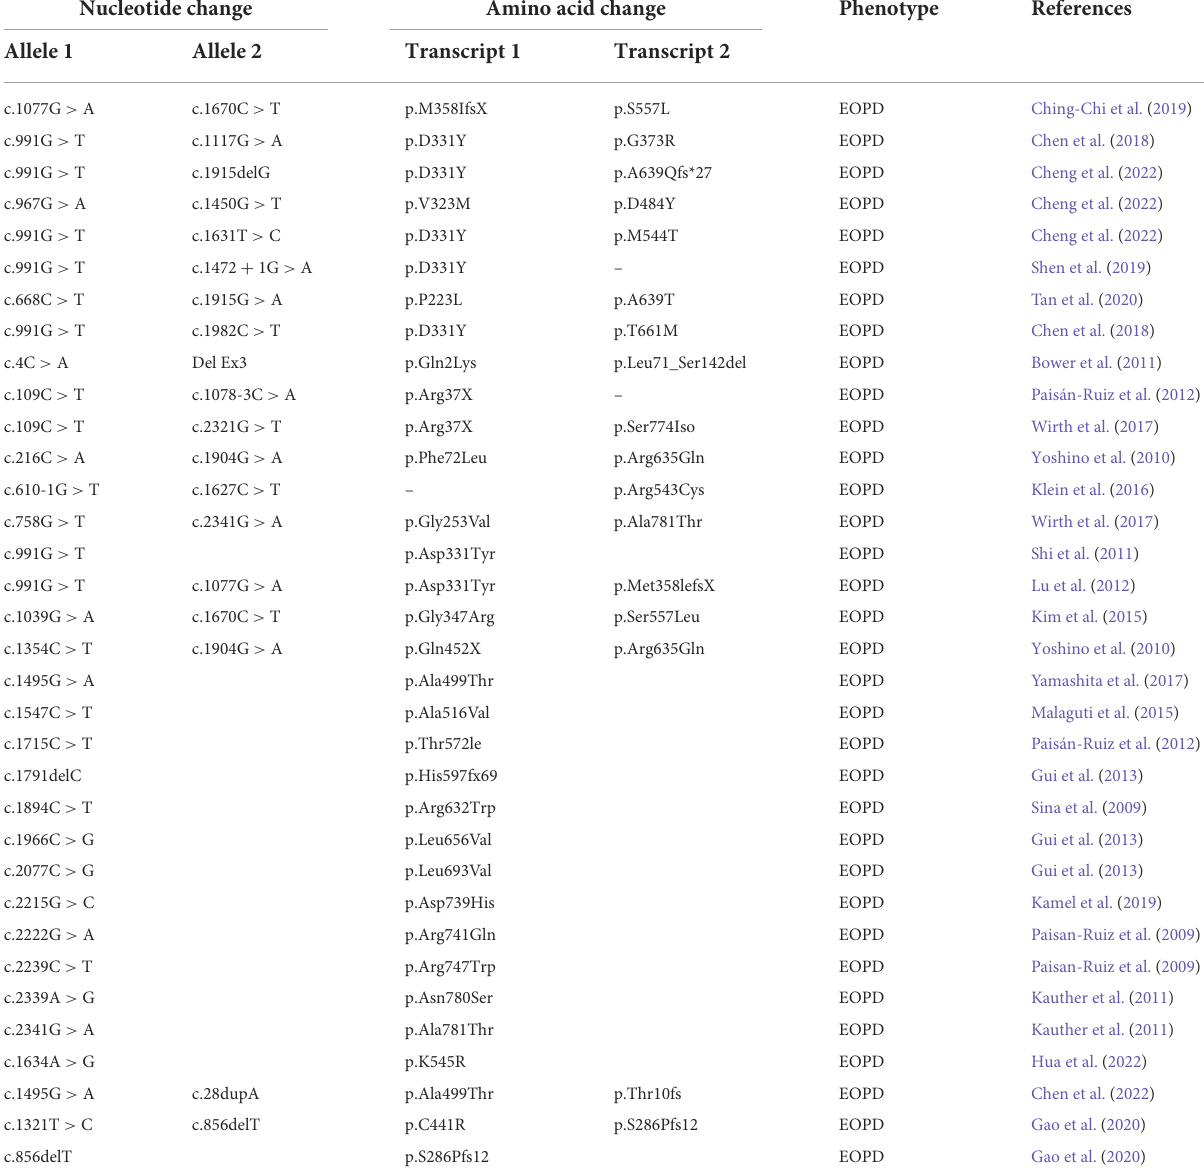
TABLE 1 Summary of all variant sites of EOPD caused by PLA2G6 mutation. Nucleotide